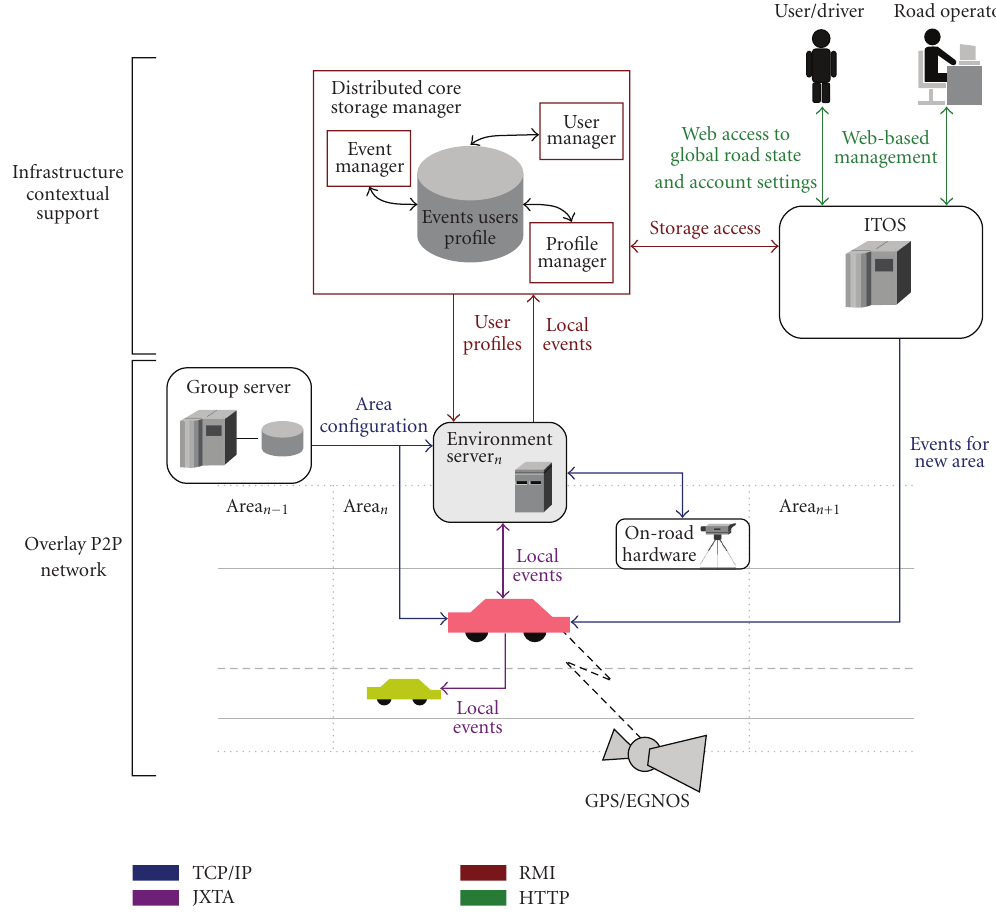
Figure 1: Overlay communication architecture and information processing